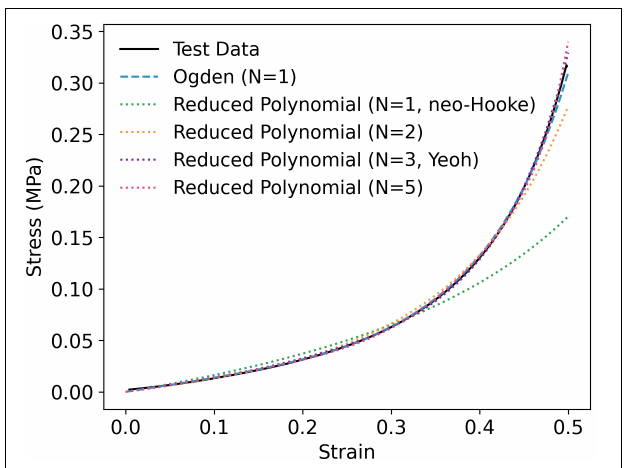
FIGURE 3 | Representative curve fit of stable hyperelastic models to uniaxial compression data, taken from an individual P 9 G 1 -A-C sample.